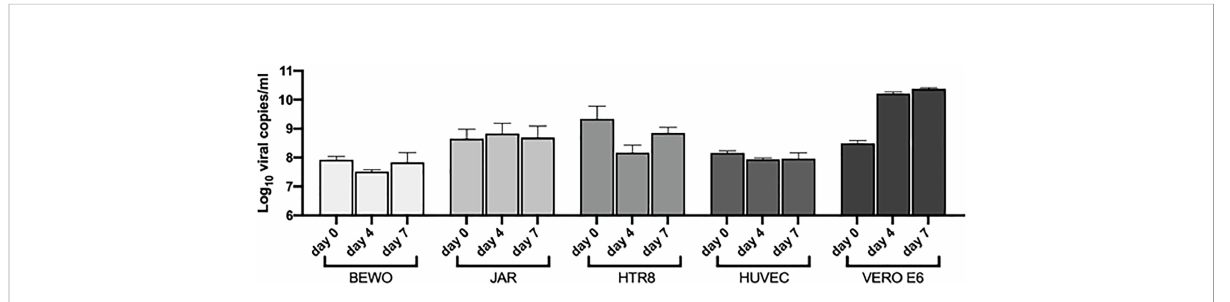
FIGURE 7 Quanti fi cation by RT-qPCR of SARS-CoV-2 RNA presence in the supernatant of cells incubated with the virus. VERO E6 were used as a control. The viral load was displayed as Log 10 viral copies/ml (mean ± SD) at day 0, 4 and 7 post